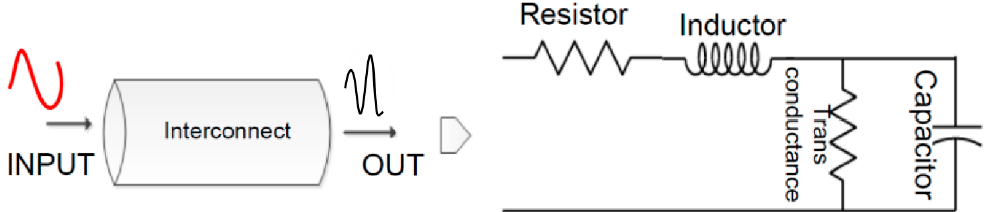
Figure 5. A resistor, inductor, capacitor (RLC) model of an interconnect. The model highlights the various passive elements that are present in a simple interconnect or wire, which effects the integrity of signals.